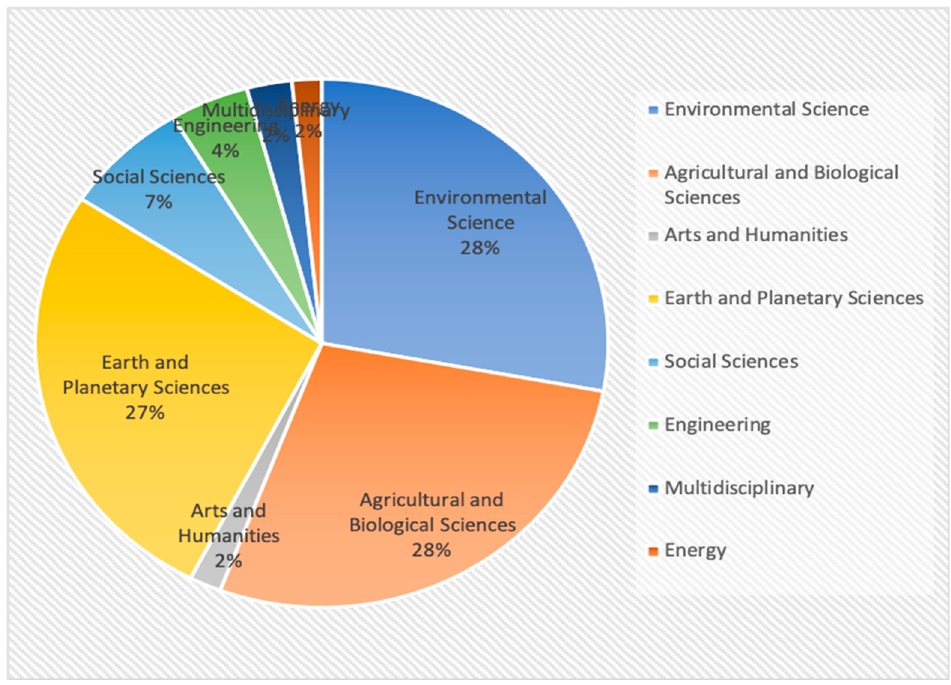
Figure 2. Subject areas that contribute to drought analysis.